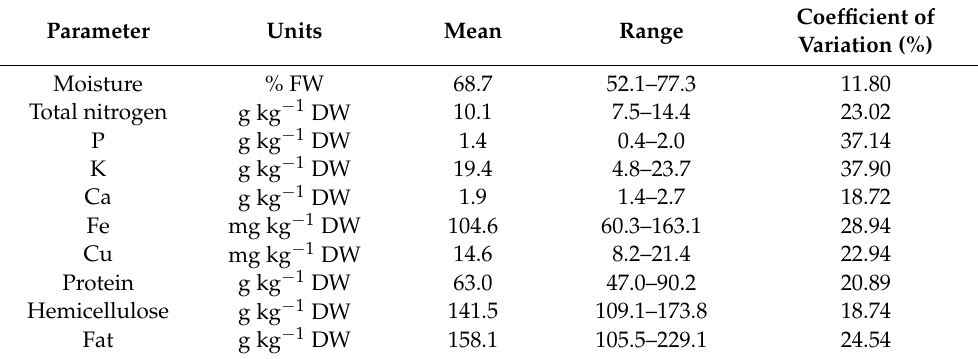
Table 1. Main characteristics and components of the two-phase olive-mill